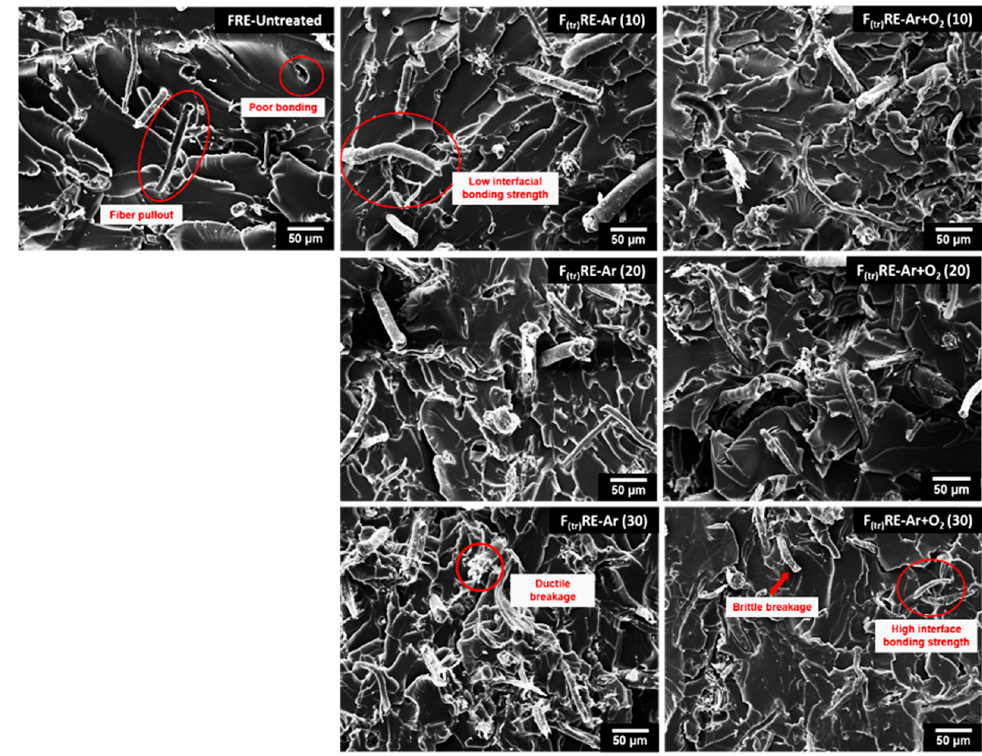
Figure 11. SEM images of fractured surfaces of BF/epoxy mixture samples with untreated fi bers and fi bers treated with Ar gas and Ar + O 2 gas for various treatment times. fibers treated with Ar gas and Ar + O 2 gas for various treatment